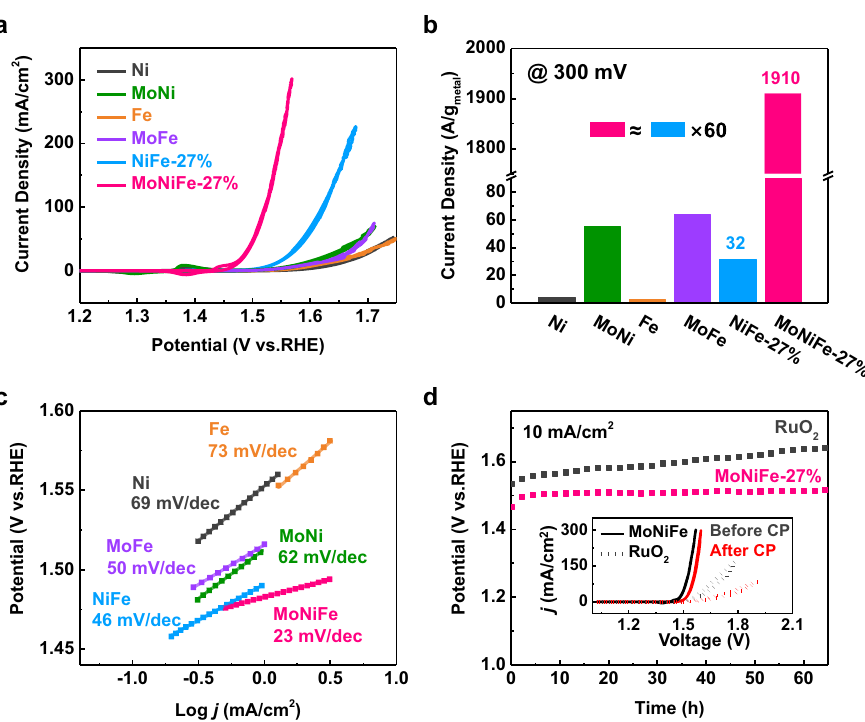
Fig. 2 OER performance of the NiFe and MoNiFe (oxy)hydroxides. a Cyclic voltammetry polarization curves, b mass activities and c Tafel curves of Ni, MoNi, Fe, MoFe, NiFe-27%, MoNiFe-27% (oxy)hydroxide. d Chronopotentiometry curves at the current density of 10 mA/cm 2 for MoNiFe-27% (oxy) hydroxide and commercial RuO 2 . The inset fi gure is the corresponding cyclic voltammetry polarization curves before and after chronopotentiometry